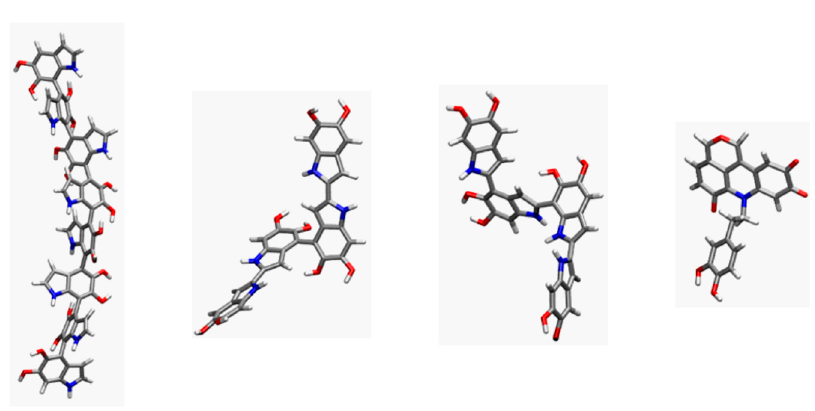
Figure 5. Examples of representative conformations from the molecular dynamics trajectories for individual units for the four PDA models considered, in the MD simulations with explicit solvent (left to right: l DHI, TET-1, TET-2, and PYR).